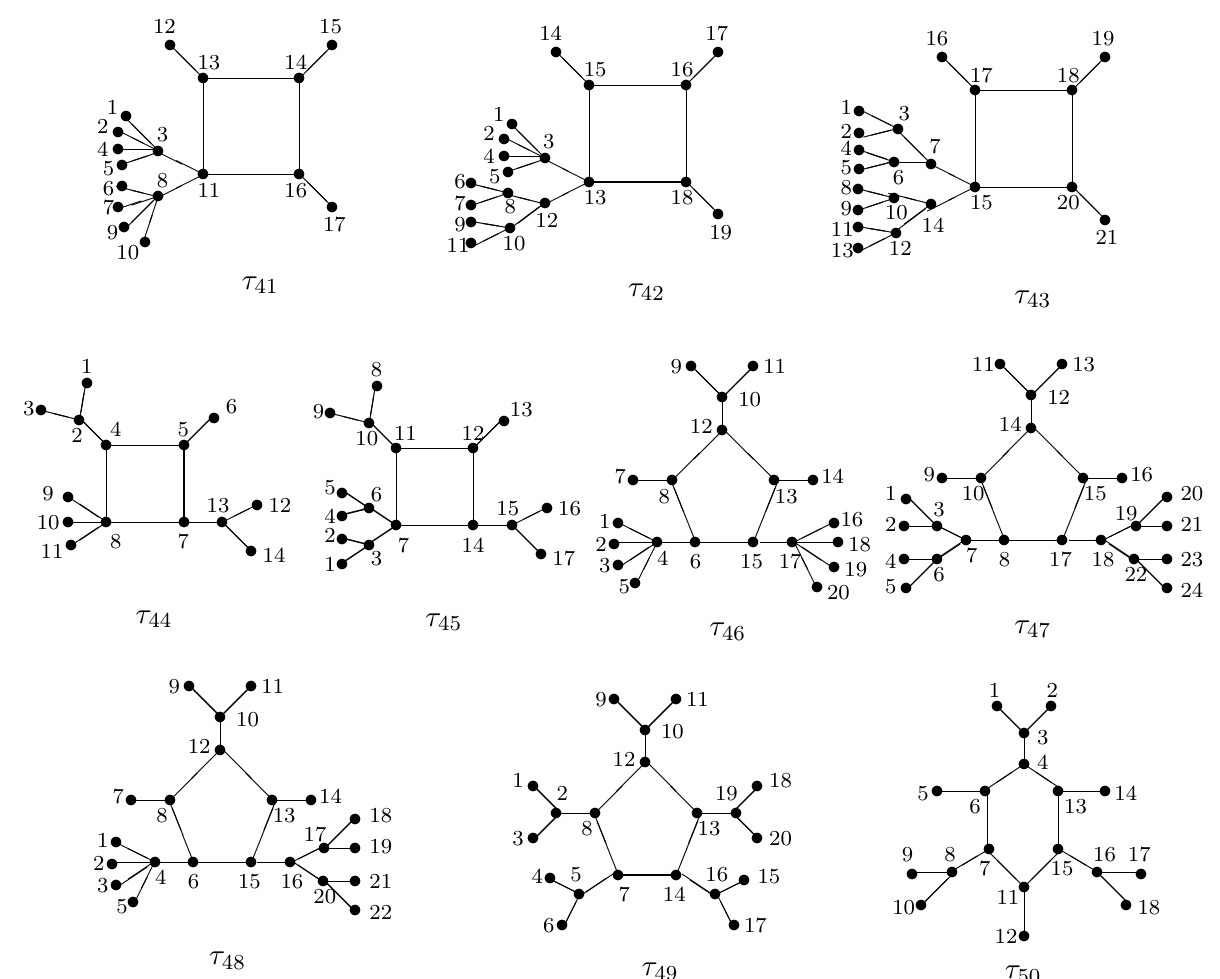
Fig.3. All 4-cutwidth critical unicyclic graphs with optimal labelings Figure 3. All 4-cutwidth critical unicyclic graphs with optimal